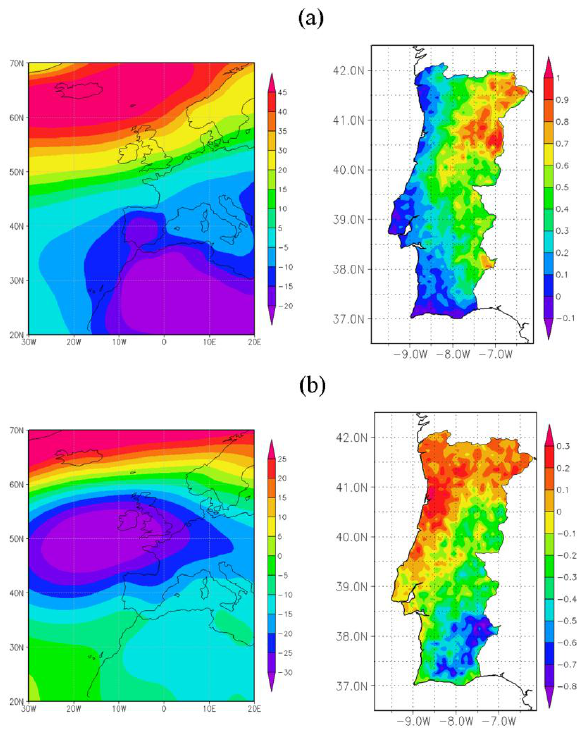
Fig. 9. Leading two coupled modes between the monthly mean JRA 1000hPa geopotential height (left panels; in gpm.SD − 1 ) and the monthly totals of CGD days (right panels; in discharges.SD − 1 ) over Portugal in 2003–2009. The canonical correlations are of 0.50 and 0.27, respectively, both statistically significant according to the Bartlett-Lawley test.